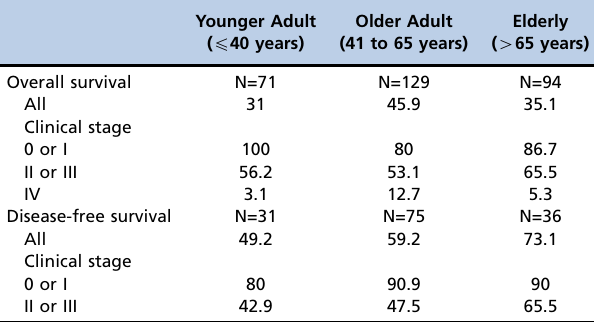
Figure 2 - Overall survival. (2a) Overall survival according to patient age group. (2b) Overall survival in clinical stages 0 and I according to patient age group (YA N=4; OA N=20; E N=15). (2c) Overall survival in clinical stages II and III according to patient age group (YA N=28; OA N=57; E N=24). (2d) Overall survival in clinical stage IV according to patient age group (YA N=36; OA N=46; Table 2 - Two-year cumulative survival rate (%). Table 2 summarize the results.